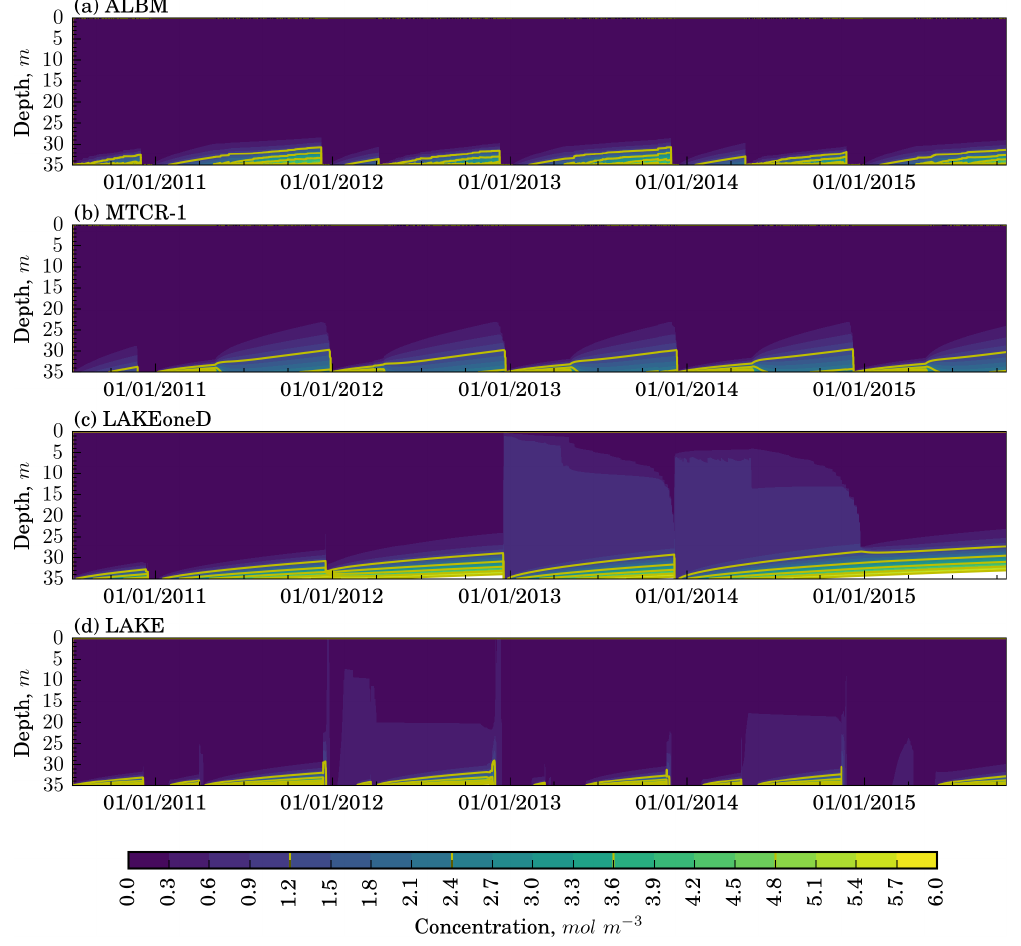
Figure 6. Vertical distribution of passive tracer concentration in Harp Lake simulations, according to different